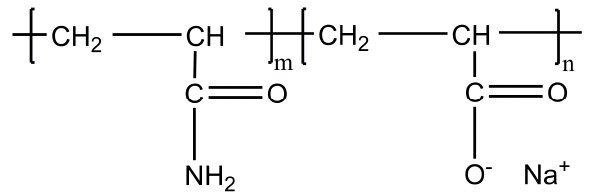
Figure 1. Copolymer of acrylamide and sodium acrylate (HPAM).